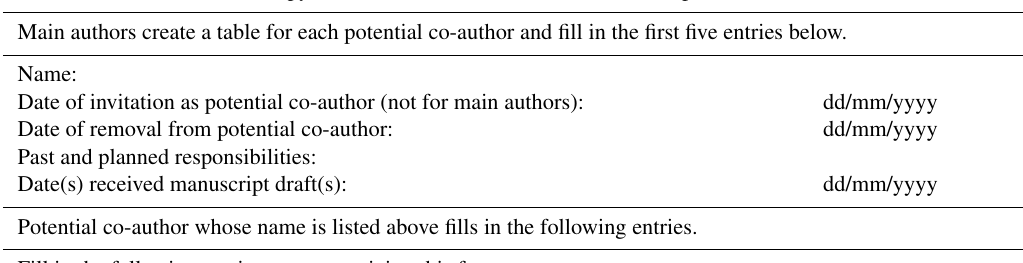
Table 2. Extract from the authorship form for each potential co-author. See Sect. S2.1 for the unabridged authorship form. Potential co-author table (a copy of this table needs to be created for each potential/main co-author) Main authors create a table for each potential co-author and fill in the first five entries